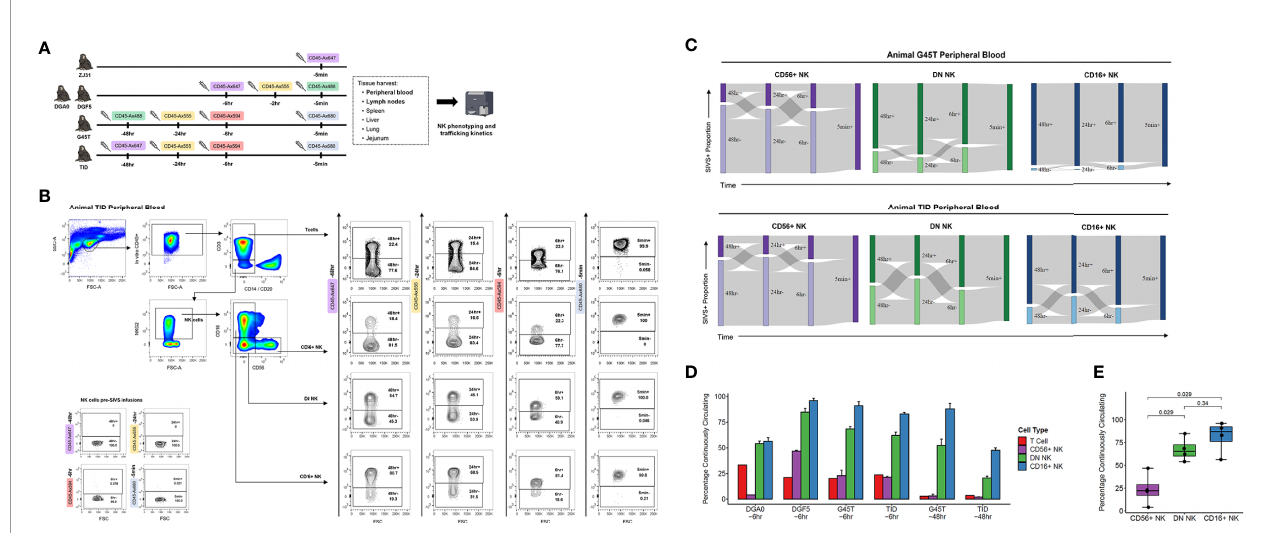
FIGURE 2 | NK cell dynamics in peripheral blood. (A) Experimental time course of SIVS injections for fi ve animals. Syringe icons indicate SIVS injections given at the time listed before euthanasia and blood sampling. Colored boxes indicate the fl uorescently labeled CD45 antibody used. (B) Representative fl ow plots for animal TID which received the 48 hour SIVS time course. Staining for each of the four SIVS antibodies is shown for T cells, CD56+ NK cells, DN NK cells, and CD16+ NK cells as well as negative control NK cells sampled prior to SIVS infusion (bottom left). (C) Sankey diagram for animal G45T (top) and animal TID (bottom) which received the 48 hour SIVS time course. Cells were recovered from blood at time zero and the times listed are hours or minutes before time zero corresponding to the SIVS infusions shown in Panel (A) Bars show the proportion stained positive/negative for the SIVS antibodies administered at each timepoint and the gray chords show the fraction of cells that transition between each combination of positive and negative between time points. (D) Percentage of “ Continuously Circulating ” in each peripheral blood cell subset, de fi ned as cells staining positive for all timepoint antibodies administered from the initial timepoint listed below the animal name through euthanasia and blood sampling. For DGA0 and DGF5, this is the fraction of cells stained positive for the SIVS antibodies given at -6hr, -2hr, and -5min. For “ G45T -6hr ” and “ TID -6hr ” , this is the fraction of cells stained positive for the -6hr and -5min SIVS antibodies. For “ G45T -48hr ” and “ TID -48hr ” , this is the fraction of cells stained positive for the -48hr, -24hr, -6hr and -5min SIVS antibodies. Bars show the mean and error bars show the standard error of the mean between 2 technical replicates for each cell sample. (E) The fraction of cells Continuously Circulating for up to 6 hours for each of the four animals in panel (D) Each dot shows the mean from one animal. The box shows interquartile range and the black line shows the median value for each NK cell subset. The whiskers extend to the furthest data point, and p-values shown were computed using a Wilcoxon test between each NK